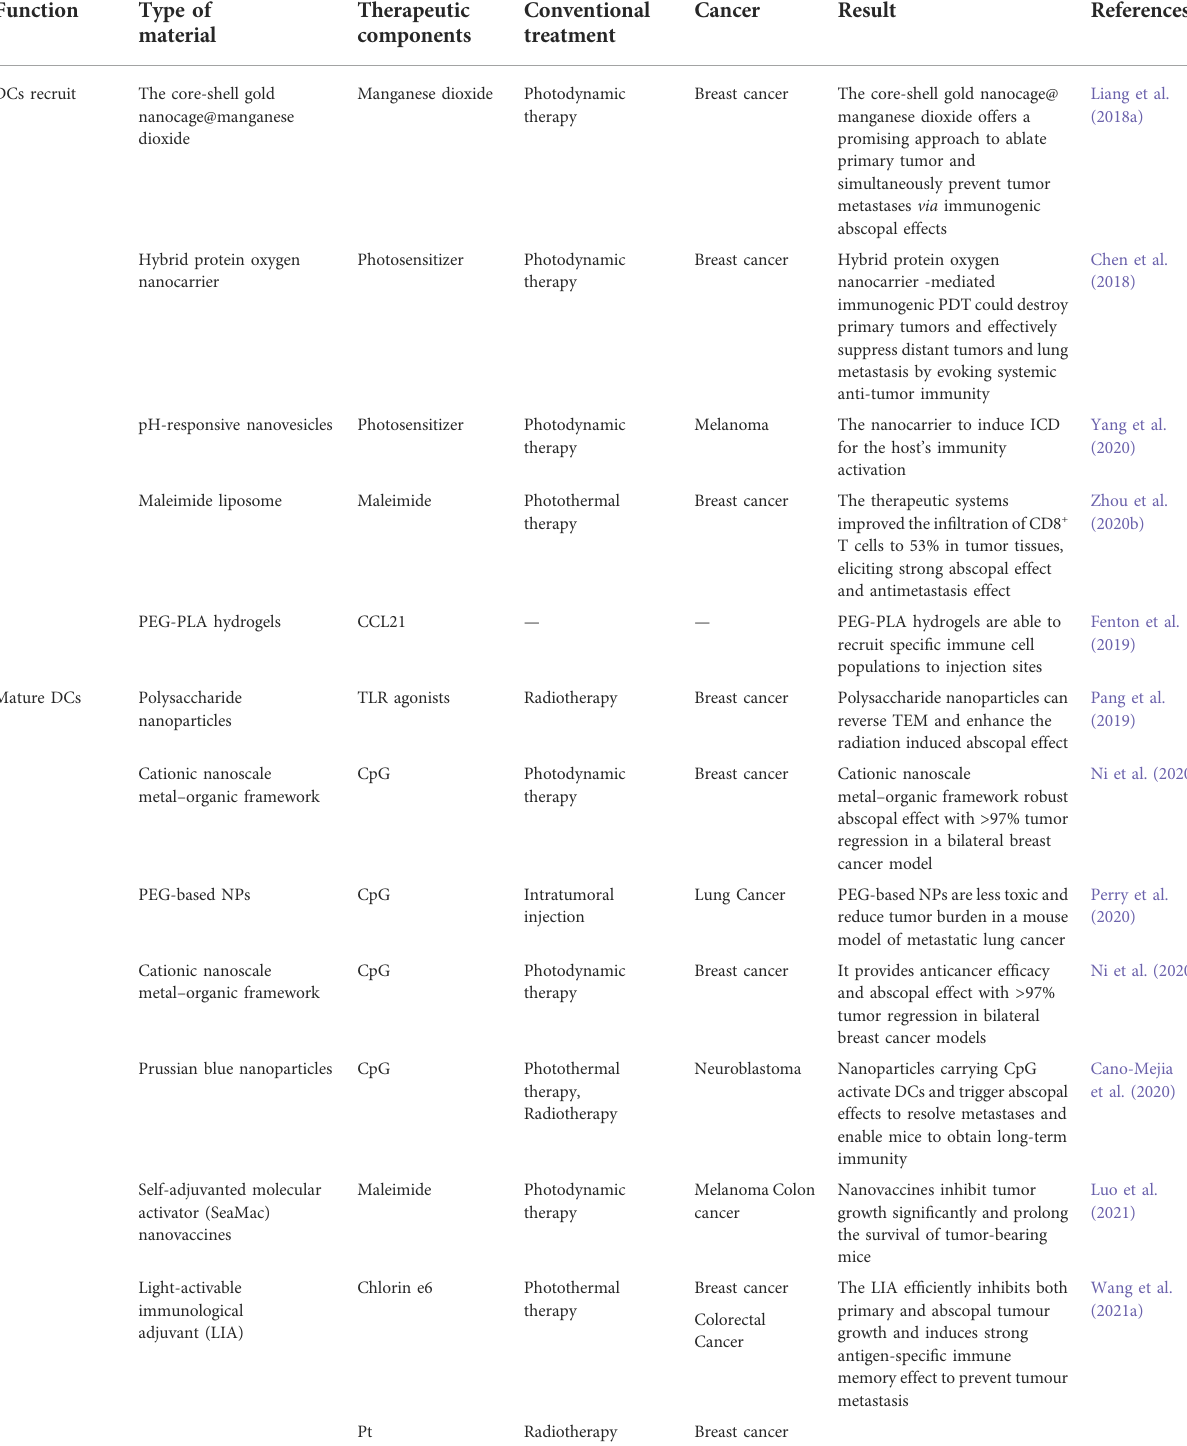
TABLE 1 Nanomaterials trigger abscopal effect for immunotherapy of metastatic